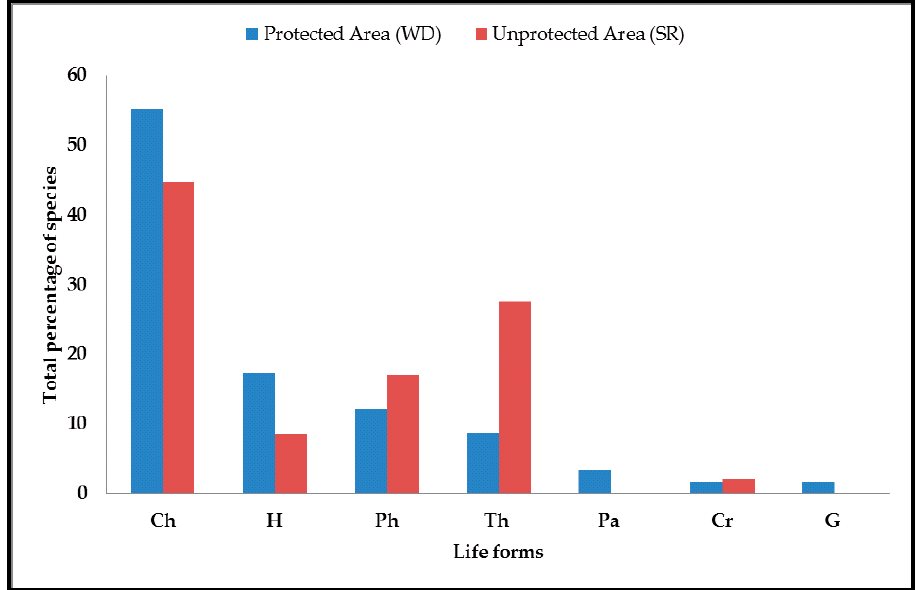
Figure 2. Spectrum of life forms in the studied areas. Ch = chamaephytes, H = hemicryptophytes, Ph = phanerophytes, Th = therophytes, Pa = parasites, Cr = cryptophytes, G = geophytes. Haloxylon salicornicum had its highest frequency value (f = 79%) in the unprotected area (SR), and Zilla spinosa and Zygophyllum coccineum were the dominant species with the highest frequency values in both areas (Table S1). Eight dominant species (f = 91–100%) were consistent in the WD. Twenty ‐ nine species (34% of the recorded flora) were consid ‐ ered singletons as they were recorded in one sample plot. Chorologically, the Saharo ‐ Ara ‐